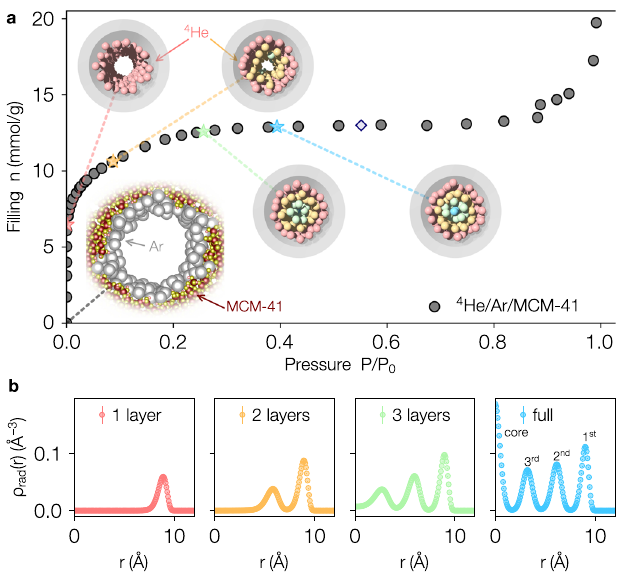
Fig. 1 Adsorption and structure inside nanopores. a Dark gray circles illustrate the adsorption behavior of 4 He at 4.2 K into MCM-41 pre-plated with a monolayer of Ar gas as the pressure is increased. Here P 0 is the bulk equilibrium vapor pressure of 4 He. The colored stars indicate the fi llings where completion of 4 He layers occurs with the call-out inset images showing quantum Monte Carlo con fi gurations of a cross-section of MCM- 41 with an equilibrated Ar layer (light gray spheres) at P / P 0 = 0, and the developing layers of 4 He (1 layer to 3 layers plus central core) as the pressure is increased. Here the Ar is represented as a cylindrical shell for clarity. The light purple diamond indicates the fi lling at which experimental inelastic neutron scattering measurements were performed at Q in = 4.0 Å − 1 corresponding to completely fi lled pores. b Quantum Monte Carlo results with binned stochastic errorbars for the radial number density of atoms ρ rad ( r ) inside nanopores at T = 1.6 K where the scattering experiments were performed. Colors correspond to the starred fi lling fractions in a . As the pressure is increased, the 4 He atoms form a series of concentric layers, with the density of the outer layers also